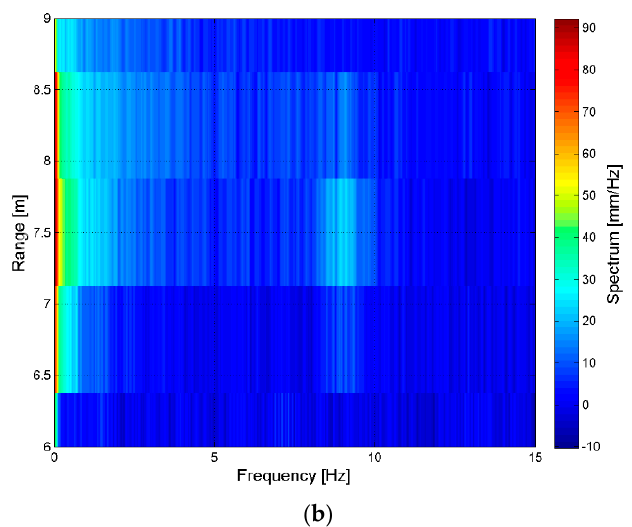
Figure 18. San Pietro dam, Aquilonia. Monitoring of the chalice-shaped spillway. Maps with ( a ) displacement time-series and ( b ) vibration spectrum of targets located at range distances between 6 and 9 m.